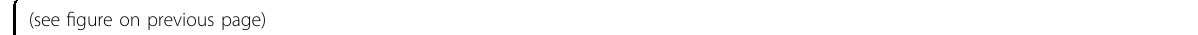
Fig. 1 AXL and β -catenin expression and their role in CLL B-cells co-cultured with BMSCs. A Increased AXL and β -catenin expression in CLL B- cells. AXL and β -catenin protein levels were determined using separated CLL B-cell lysates after 48 h of co-culture. Actin was used as a loading control . B Surface AXL expression on CLL B-cells with or without co-culture with BMSCs. Percent expression of AXL on CD5 + CD19 + B-cells ( n = 7) surface were determined after 48 h of co-culture with and without with BMSCs ( n = 6) by fl ow cytometry. C Representative histograms for surface AXL staining on B-cells (red) from two representatives CLL patients (P36, P37) compared to an isotype control (black) ( I ) and when co-cultured with (red) or without (blue) BMSC (P17) ( II ). D Co-culture of Mino, Raji, and SU-DHL4 cells with BMSCs. Lymphoma B-cell lysates from Mino or Raji or SU- DHL4 cells co-cultured with or without primary BMSCs were analyzed for the AXL and β -catenin expression by WB analysis. Actin was used as a loading control. E , F AXL and β -catenin mRNA expressions in CLL B-cells in co-culture with or without BMSCs. AXL and β -catenin mRNA expressions were determined in the CLL B-cells by real time (RT)-PCR. Results are presented as mean values with standard deviation (SD). G AXL and β -catenin expressions in CLL B-cells; direct contact versus using transwell. AXL and β -catenin protein levels were examined in CLL B-cell lysates cultured using transwells or in direct contact with BMSCs for 48 h. Actin was used as a loading control H Activation of ERK-42/44 in CLL B-cells co-cultured with BMSCs. CLL B-cell lysates were analyzed for the status of P-ERK-42/44 and P-AKT(S473). Total ERK-42/44 and AKT were used as loading controls. I P- AXL (Y702) levels in CLL B-cells co-cultured with or without BMSCs. CLL B-cell lysates were examined for the levels of P-AXL(Y702), AXL, P-AKT(S473), AKT, and β -catenin. Actin was used as a loading control. J Total tyrosine phosphorylation on AXL in CLL B-cells co-cultured with or without BMSCs. AXL was immunoprecipitated from the CLL B-cell lysates, followed by Western blot analysis using anti-phosphotyrosine (4G10) antibody. The blot was stripped and reprobed with an antibody to AXL. IgG HC was used as a loading control. K – O Impact of fl udarabine (FU) [3.5 μ M],